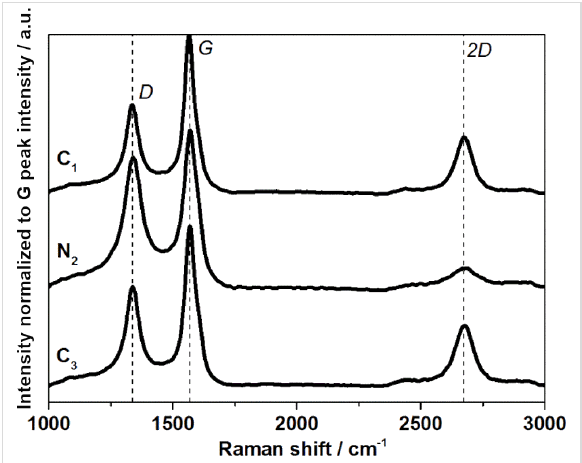
Figure 2: Raman spectra of each section of a C 1 /N 2 /C 3 structure.